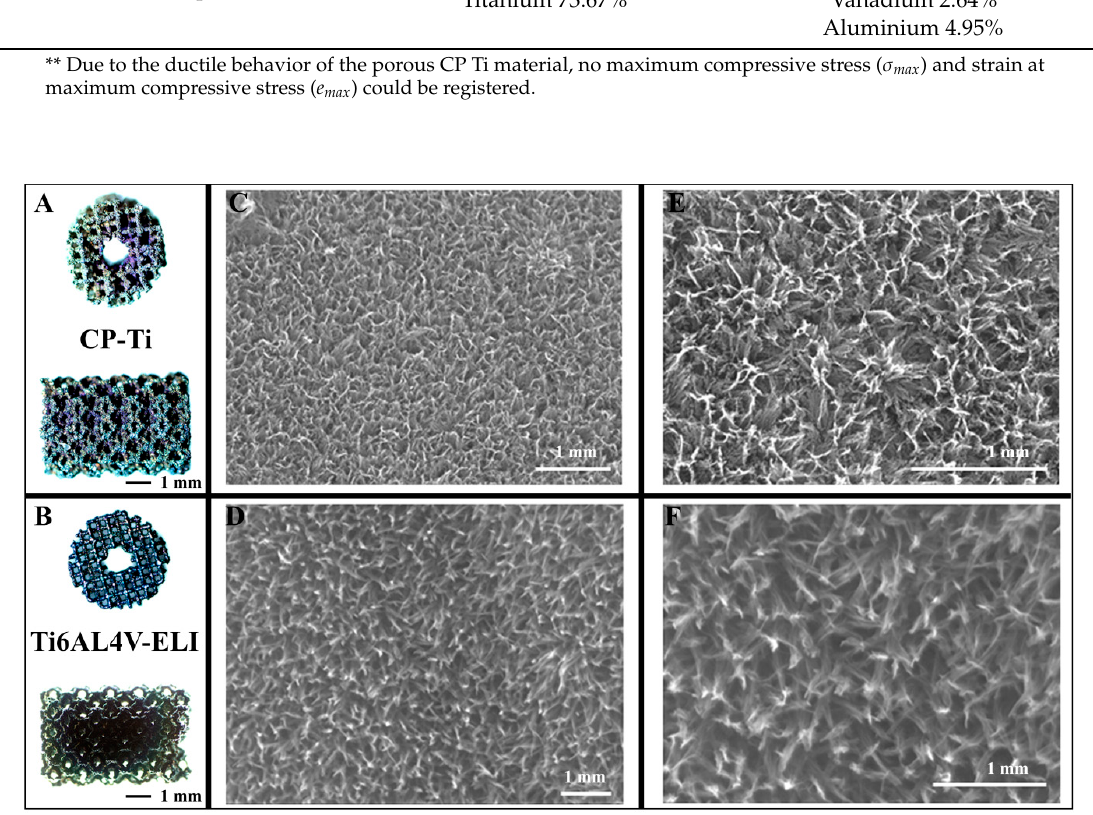
Figure 2. SEM images of CP-Ti and Ti6Al4V ELI porous implants. Macroscopic overview ( A , B ), and enlarged details ( C – F ) of the two di ff erent porous titanium implants. Panels ( E , F ) are zoomed in enlarged details ( C – F ) of the two different porous titanium implants. Panels E , F are zoomed in pictures of panels ( C , D pictures of panels C , D .